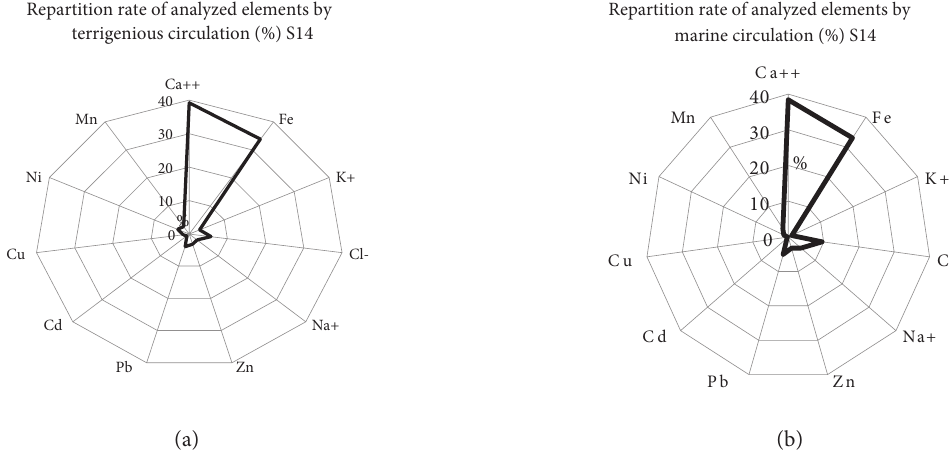
Figure 5. Repartition rate (%) of biweekly fluxes constituents of particle deposition by terrigenious (a) and marine (b) circulations (Case of S14 site)